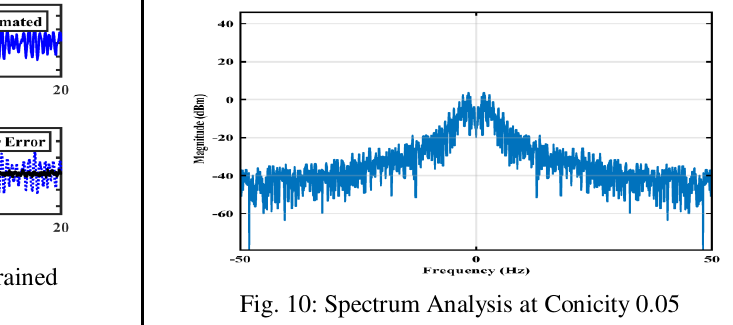
Fig. 8: Lateral Acceleration of Unconstrained Wheelset ( λ ) w = 0.25